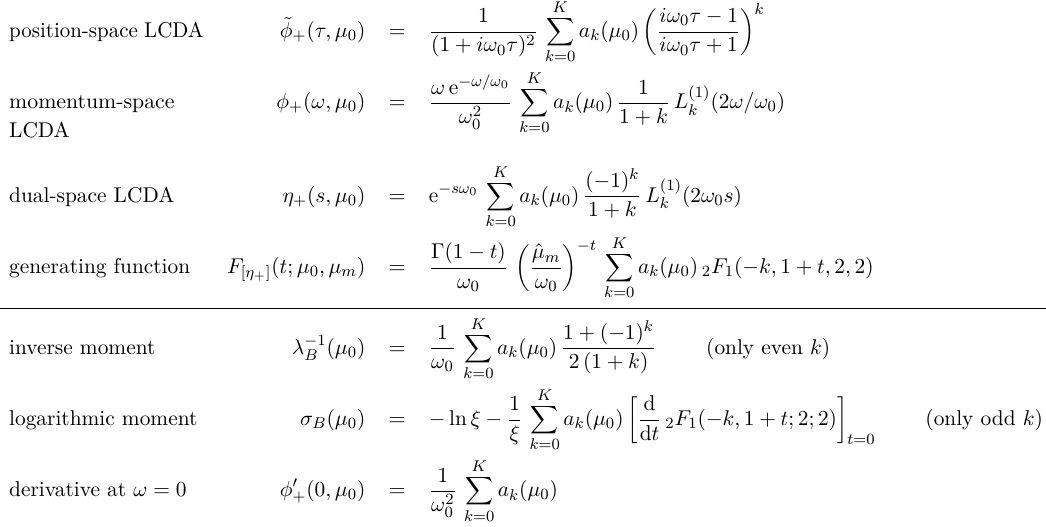
Table 1 . Summary of representations and pseudo observables connected to the leading-twist B - meson LCDA within our proposed parametrization at the low-energy reference scale µ are associated Laguerre polynomials, and ξ = ω